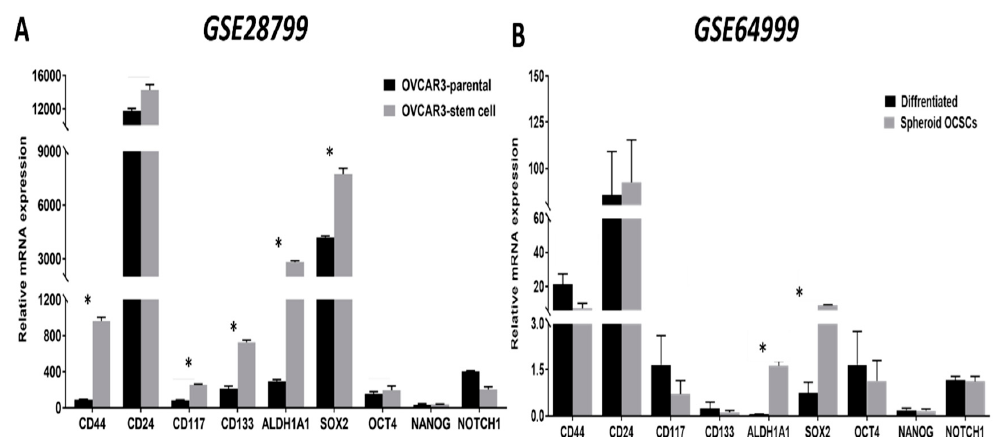
Figure 2. Expression of OCSC markers in OvCa stem cells and their parental cells. Bars represent mean ± SEM of the relative mRNA expression of the indicated OCSC markers in ( A ) OVCAR3 stem-cells vs. their parental cells ( n = 3 each) in GSE28799 , and ( B ) differentiated vs. undifferentiated OCSCs ( n = 4 each) in GSE64999. Significance was determined using multiple t- test and Holm–Sidak method with each row analyzed individually with p < 0.05, without assuming a consistent SD.